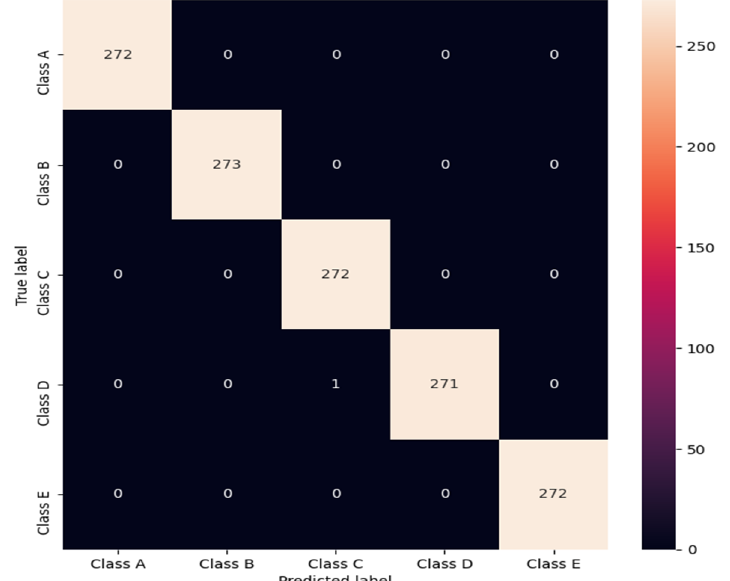
Figure 7. Confusion matrix of the proposed model.